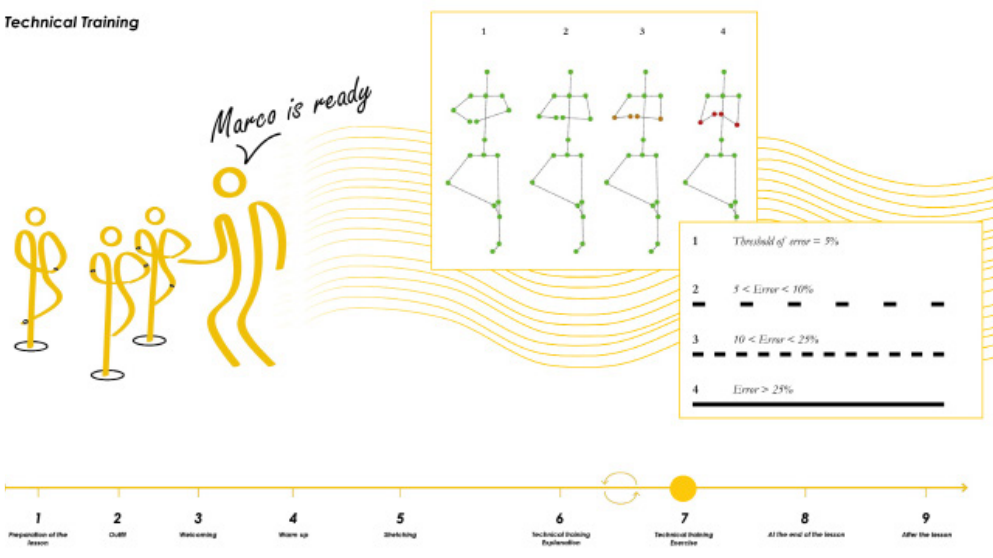
Fig. 16 Zambonini A., mock-up of the graphic interface of the PASSAY educational game: phase “technical training”,